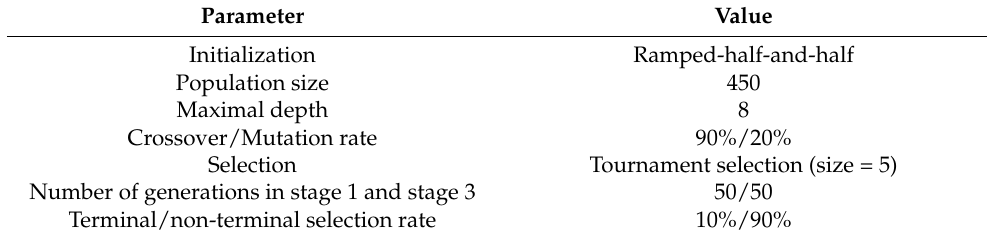
Table 3. Parameter